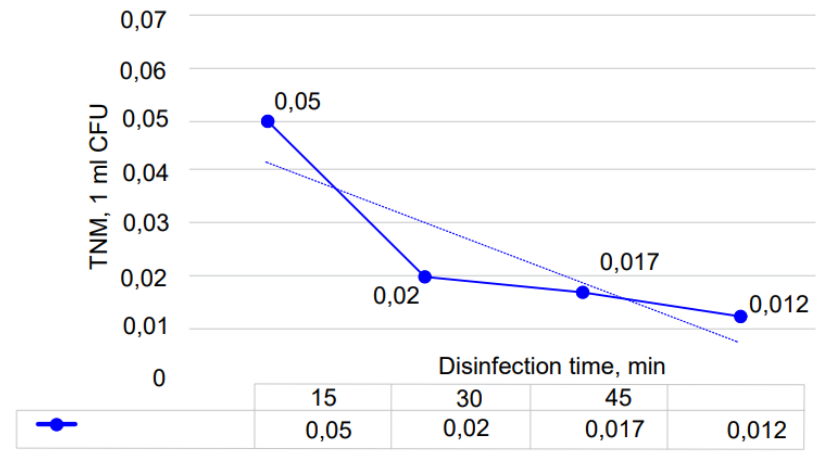
Figure 8. Algorithm of the process of destruction of harmful microorganisms in water (Gozone = const.). Must enter: T = 200C; v = 0 m/s; G = 0.6 g/h; t = var.